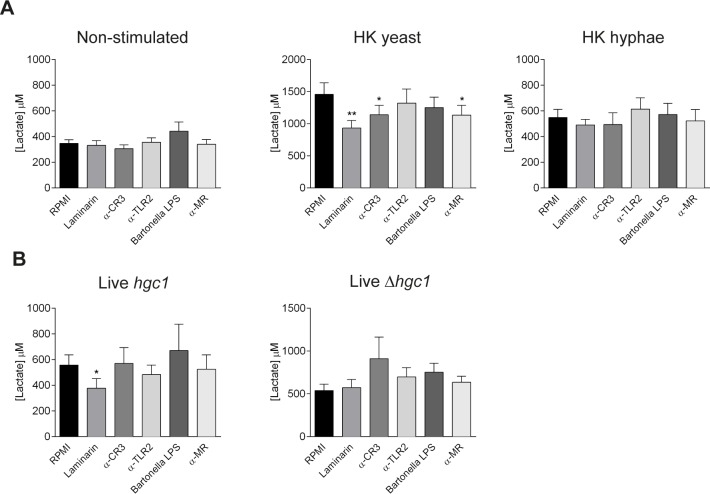
C-type lectins triggered glycolysis after stimulation with Candida yeasts.(A-B) Lactate production by human monocytes was measured after blockade of dectin-1, CR3, TLR2, TLR4 and MR and subsequent 24 h stimulation with medium, heat-killed C. albicans yeast or heat-killed C. albicans hyphae (A) or hgc1 or Δhgc1 live C. albicans (B) (mean ± SEM, n = 6; pooled from 2 independent experiments). *p< 0.05, **p<0.01 Wilcoxon signed-rank test. Results of stimulation with isotype controls are displayed in S3 Fig.